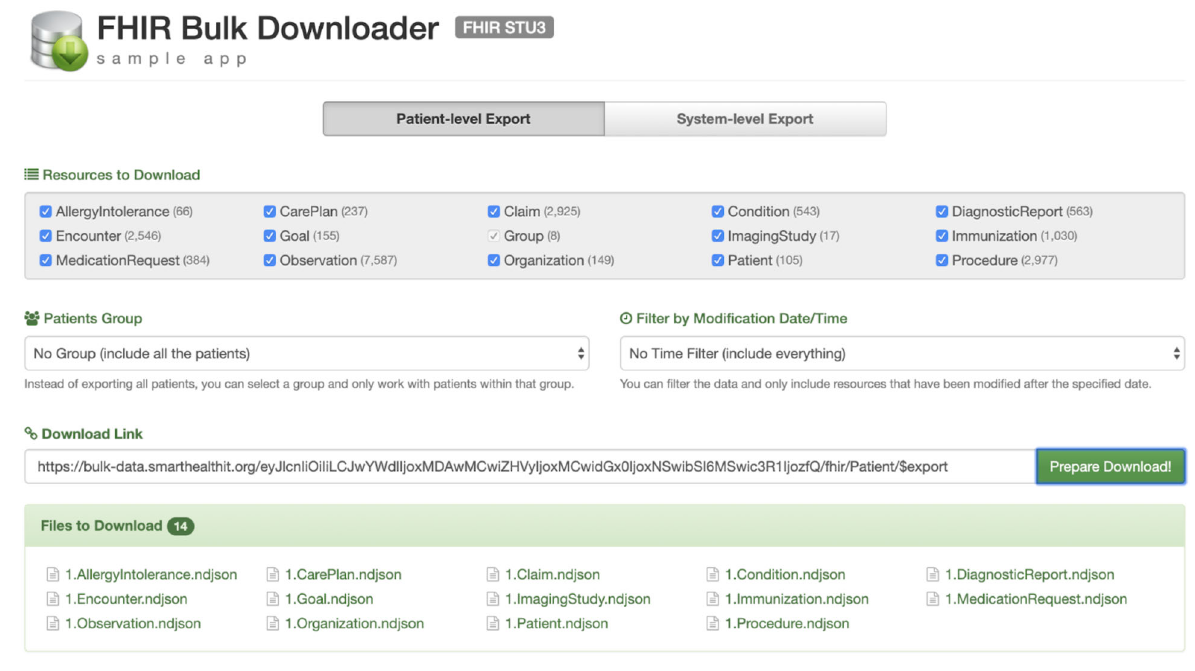
Fig. 4 Bulk Data sample app. An open-source browser-based app provides an interface for downloading data from the SMART Bulk Data Server reference implementation.